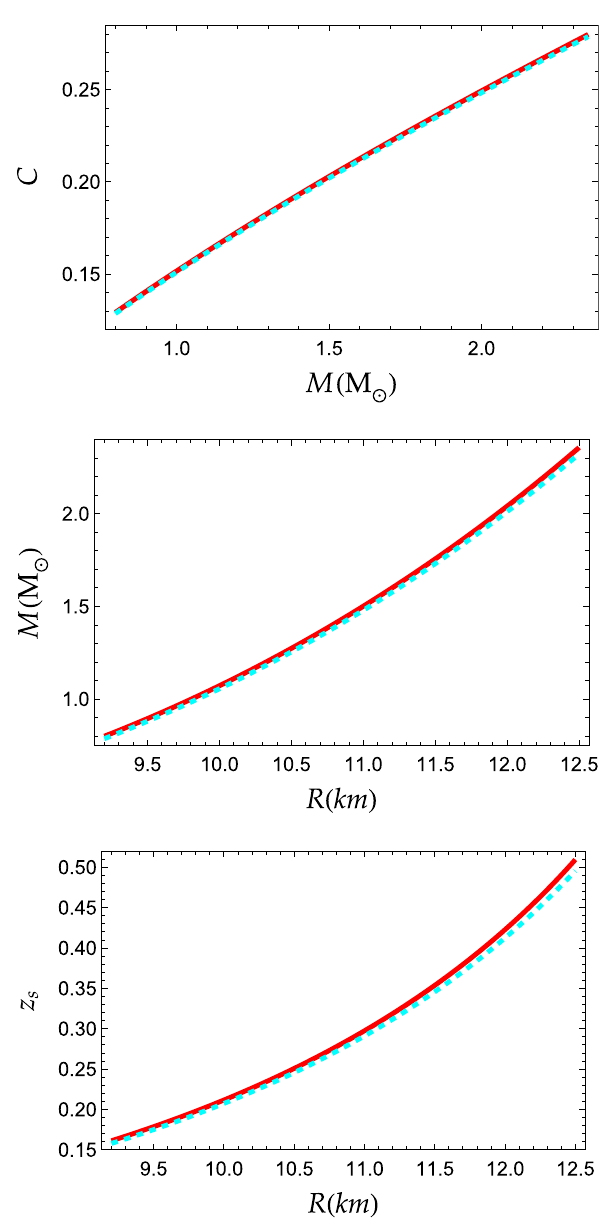
Fig. 6 Top: Factor of compactness, C , versus mass, M (in solar masses). Solid red line corresponds to the case G (cid:5) ( r = 0 ) = − 0 . 0002 / km, while dashed cyan line corresponds to the case G (cid:5) ( r = 0 ) = + 0 . 0002 / km. Middle: Mass-to-radio profiles for the two cases regarding the sign of G (cid:5) ( r = 0 ) . The color code is the same as in the top panel. Bottom: Surface red-shift, z s , (see text) versus radius R (in km). The color code is the same as in the top